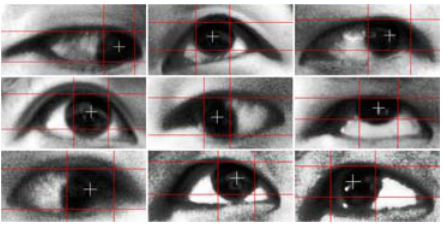
Figure 4: Results of successful rough iris center detection on eye